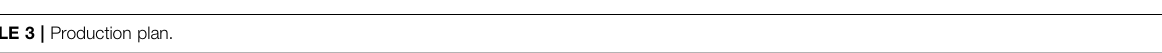
TABLE 3 | Production plan.